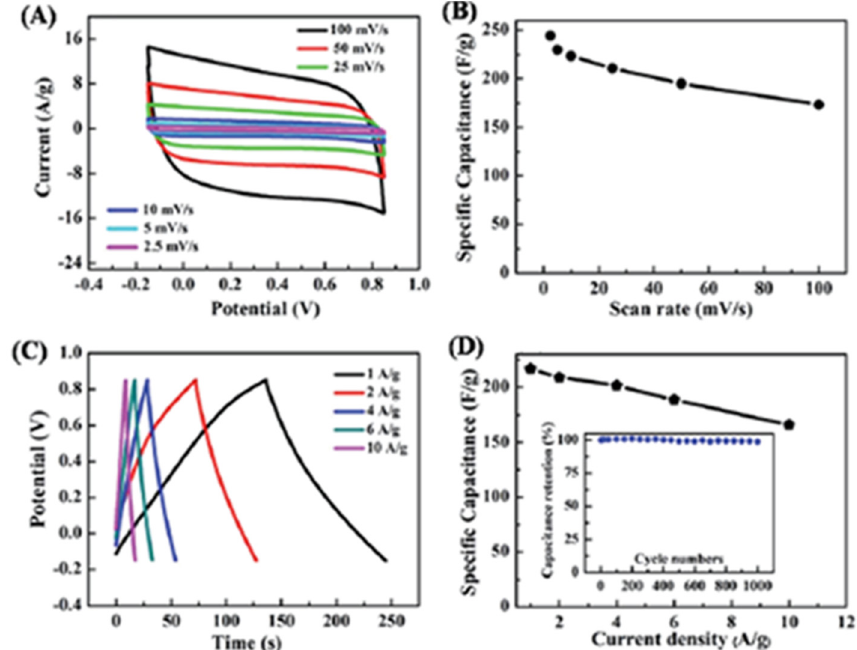
Figure 9. Electrochemical characterization of G/SWCNHs in 1 M KOH aqueous solution at room temperature. ( a ) CV curves at different scan rates. ( b ) Specific capacitance versus scan rate. ( c ) GCD curves at different current densities ranging from 1 A·g − 1 to 10 A·g − 1 . ( d ) Specific capacitance as a function of current density; inset shows capacitance retention versus cyclic number. Reproduced with permission of [81]. Royal Society of Chemistry,